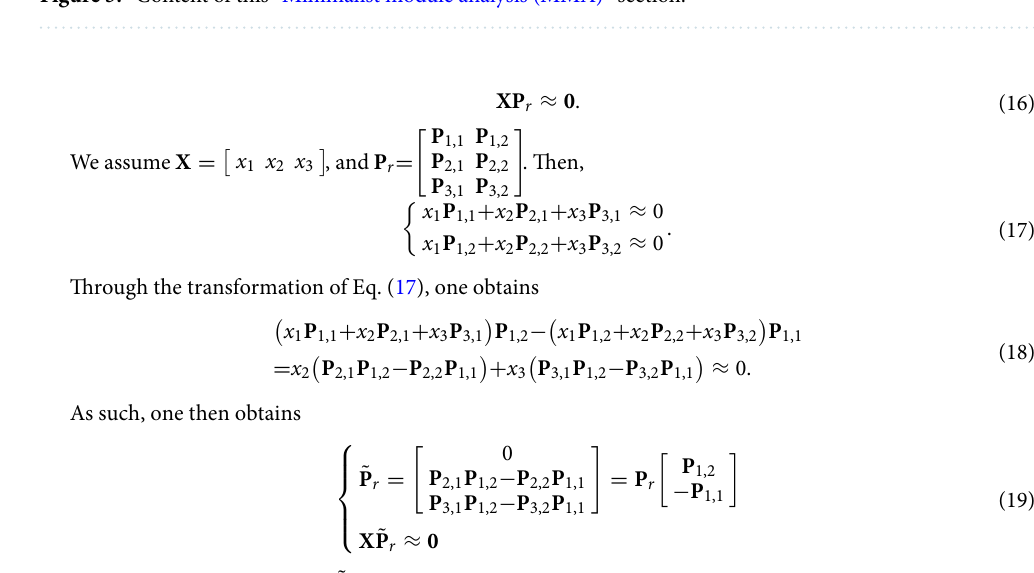
Figure 3. Content of this “Minimalist module analysis (MMA)”